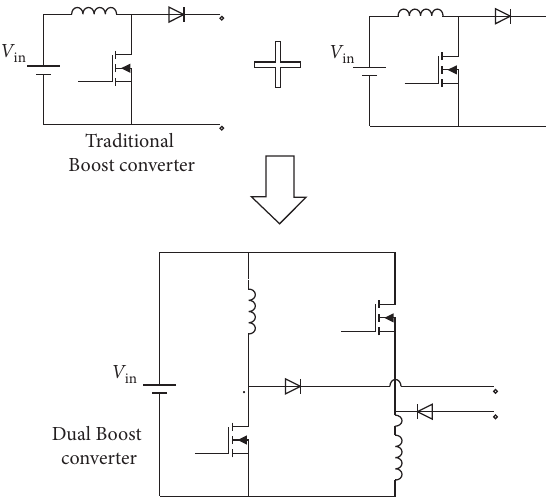
Figure 1: Parallel double-boost